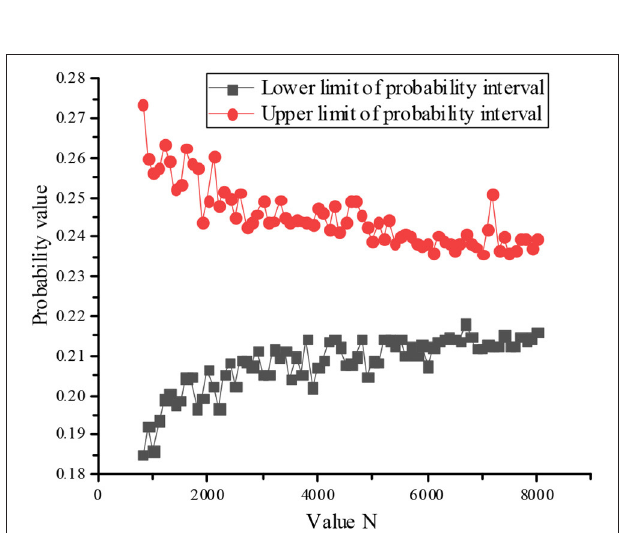
FIGURE 3 | Change law of failure probability with number change of inner layer